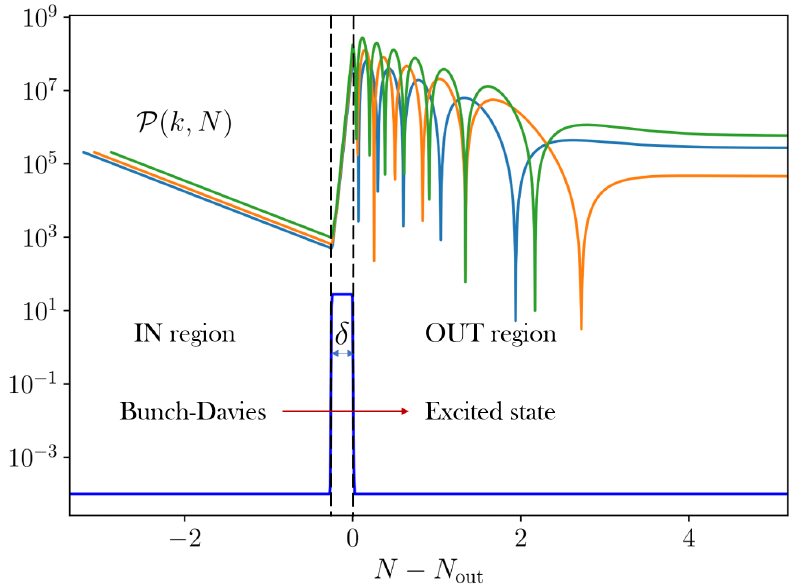
Figure 2 . Time evolution of the curvature perturbation power spectrum in presence of a sharp feature for three different k -modes (normalised to P 0 , i.e. the single-field, slow-roll primordial power spectrum). In blue, an illustrative profile for the background parameter defining the feature. At the onset of the so-called out region, the relevant modes are still deep inside the Hubble radius. By that time, the sharp feature has prepared the system in an excited state, so that the corresponding power spectrum oscillates with a k -dependent phase before freezing outside the horizon. Scalar induced GWs generated after inflation are only sensitive to the snapshot of the power spectrum of ζ at late times, i.e. the primordial curvature power spectrum. Instead, GWs generated during inflation are sensitive not only to the various degrees of freedom entering in the energy-momentum tensor but also to their time evolution during inflation. The three curves have been computed explicitly by using the example of section 4.7 with parameters ( η ⊥ , δ ) = (28 , 0 . 25)